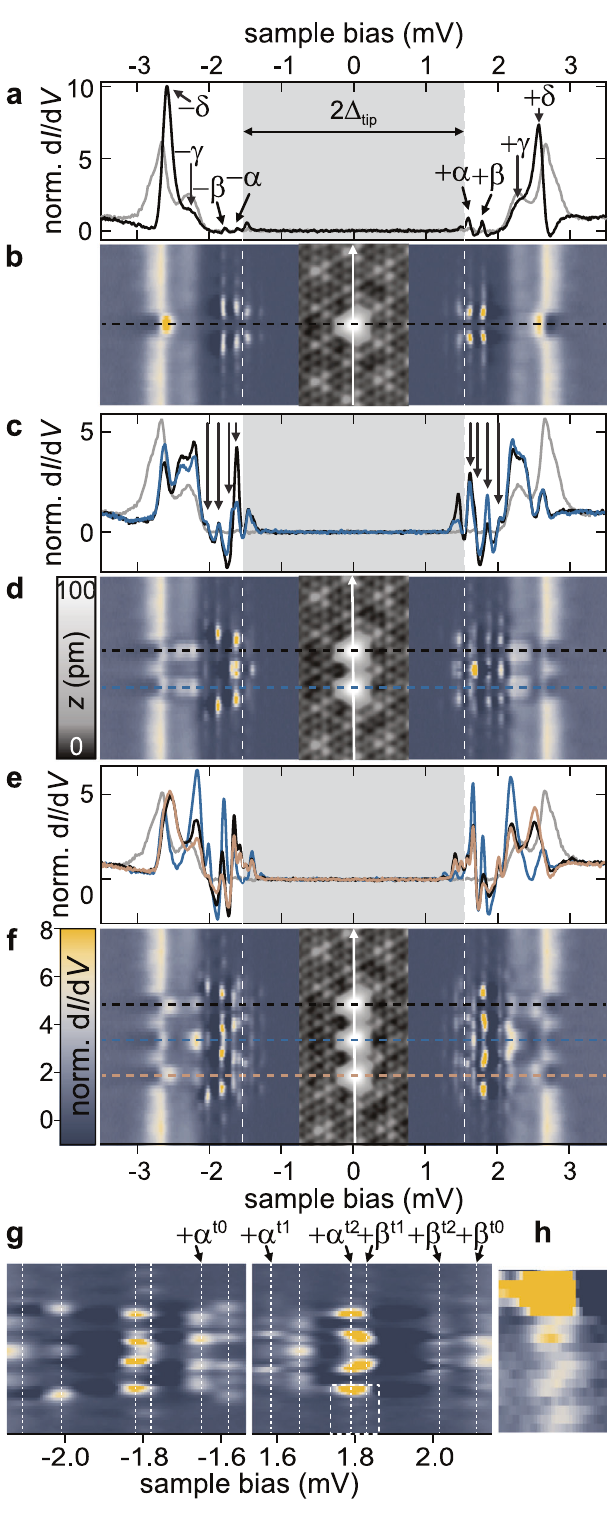
Fig. 2a (black line; tip gap indicated in gray). We resolve four pairs of subgap YSR resonances labeled α − δ at symmetric bias orbitals to corresponding conduction electron channels 18,59 ,